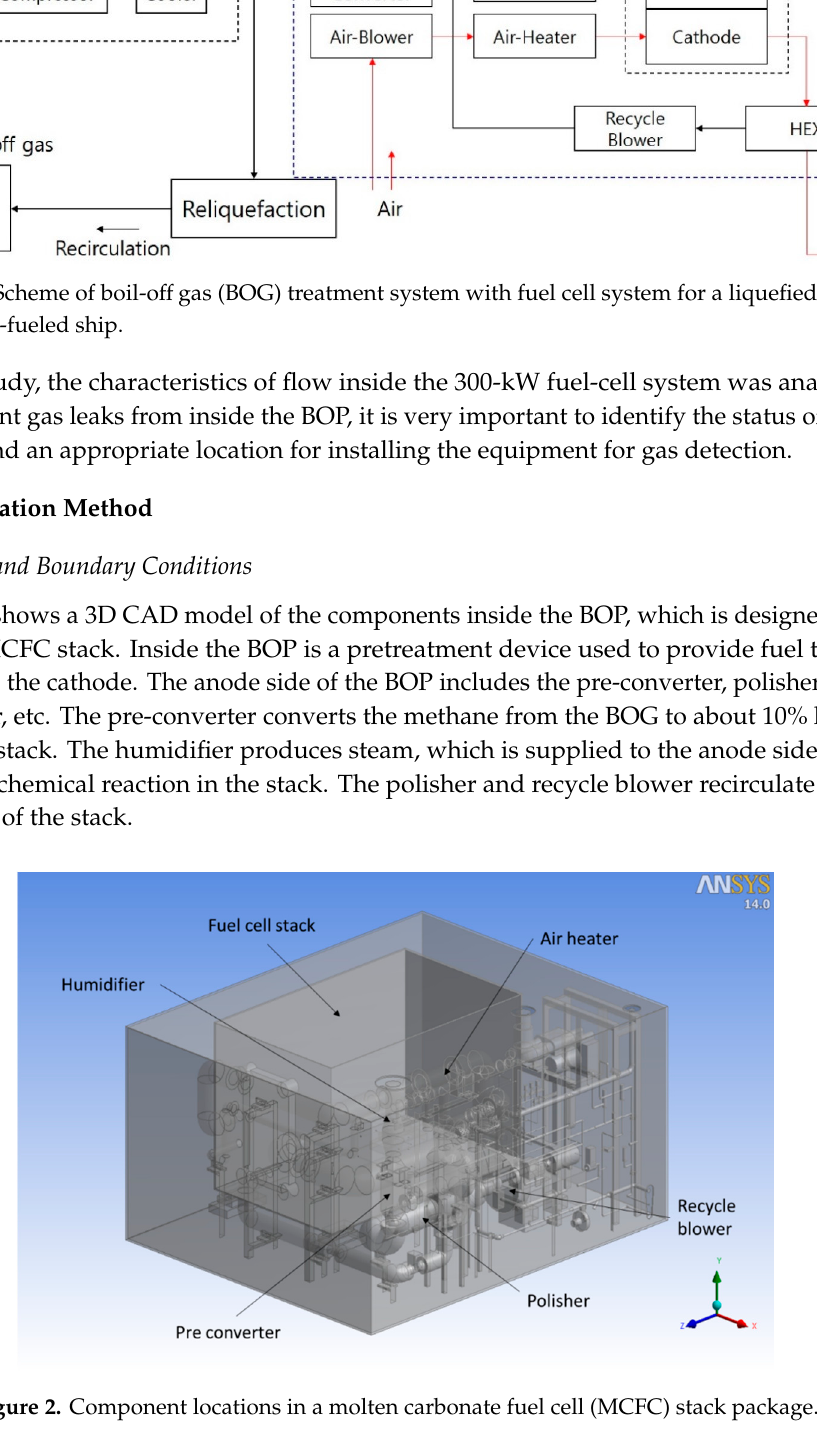
Figure 1. Scheme of boil-off gas (BOG) treatment system with fuel cell system for a liquefied natural gas (LNG)-fueled ship.